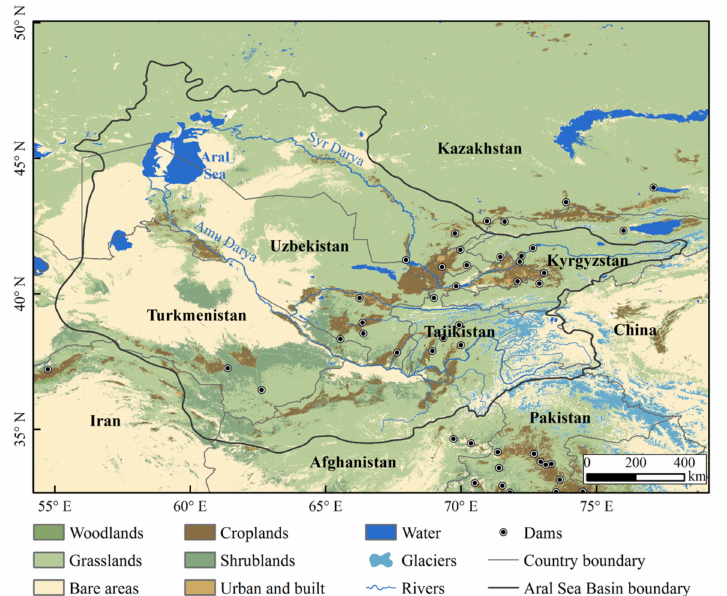
Figure 1. Land-use map of the Aral Sea Basin for the year 2002. The land-cover data were from the MODIS MCD12Q1 product, glacier data were derived from the Randolph Glacier Inventory (RGI) 6.0, and dam data were obtained from the Global Reservoir and Dam Database